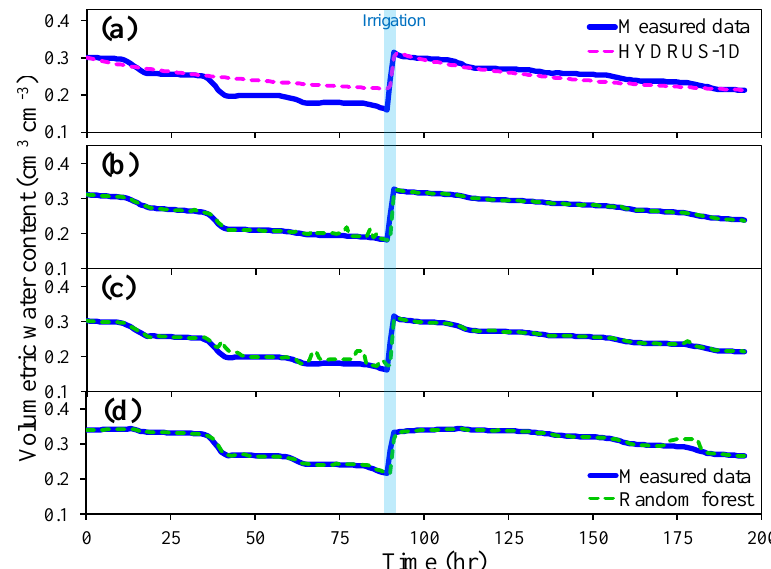
Figure 7. Soil volumetric water content simulation by HYDRUS-1D with the measured / empirical parameters in basket ( a ) No. 13. Soil volumetric water content simulation of the random forest model for baskets ( b ) No. 12, ( c ) No. 13, and ( d ) No. 14. The blue lines are the test set of the measured soil volumetric water content.